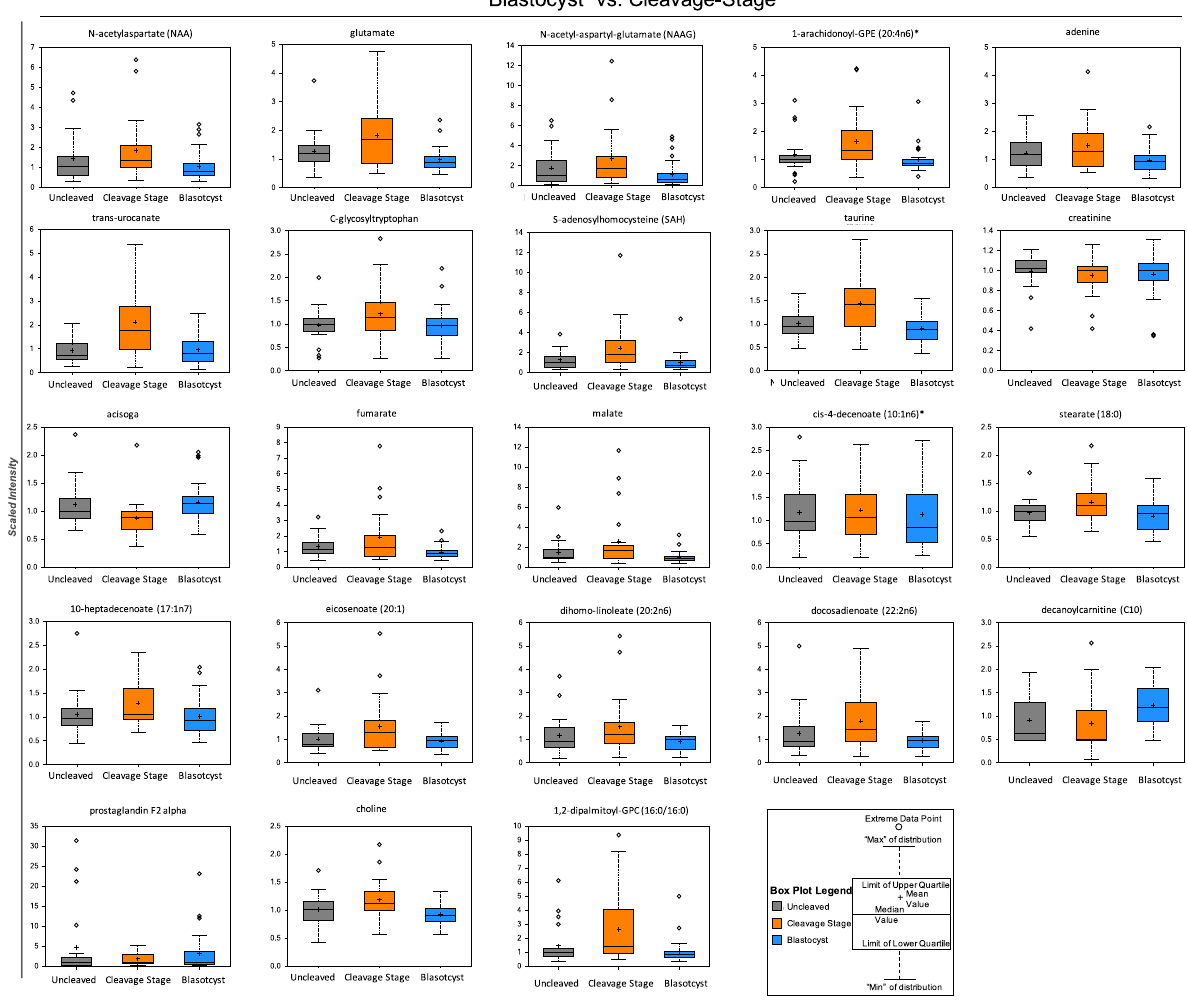
Figure 2. Representative box plots of metabolites that were significantly different between FF samples belonging to the blastocyst versus cleavage stage embryo group ( p < 0.05). The y-axis reflects the scaled intensity of each metabolite in uncleaved (gray) cleavage stage (orange) and blastocysts (blue). The original data generated by the area under curve of the MS peaks was used for median-scaling, determining the minimum and maximum of data distribution, and identification of outliers. Note that with the exception of acisoga, an end product of polyamine metabolism, and the fatty acid lipid molecule, decanoylcarnitine (C10), most of the metabolites were downregulated in blastocysts compared to cleavage stage